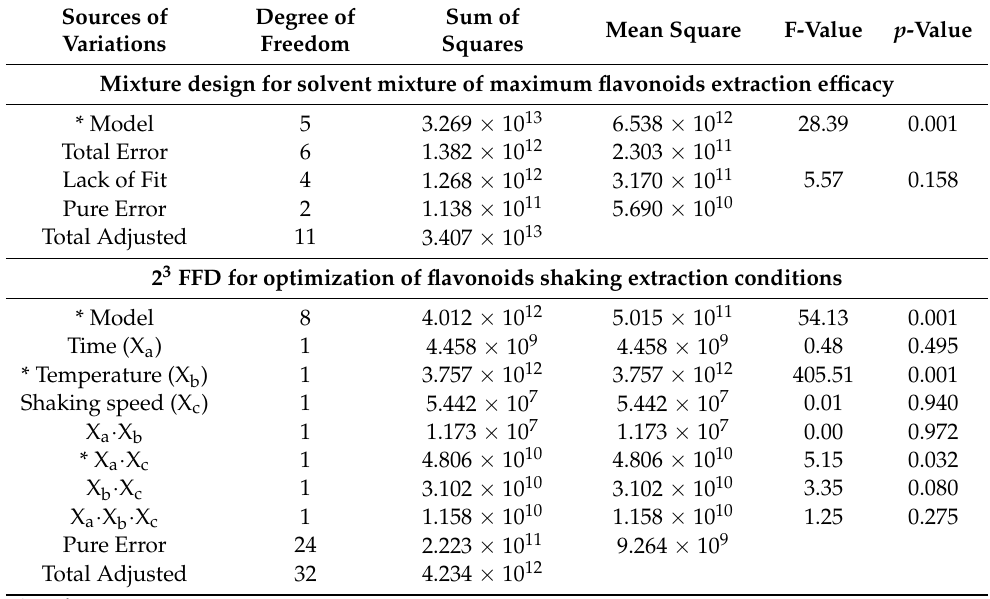
Table 2. ANOVA for the mixture design and two-level for three variables (2 3 ) FFD models. Sources of Degree of Sum of Mean Square F-Value p -Value Variations Freedom Squares Mixture design for solvent mixture of maximum flavonoids extraction efficacy *